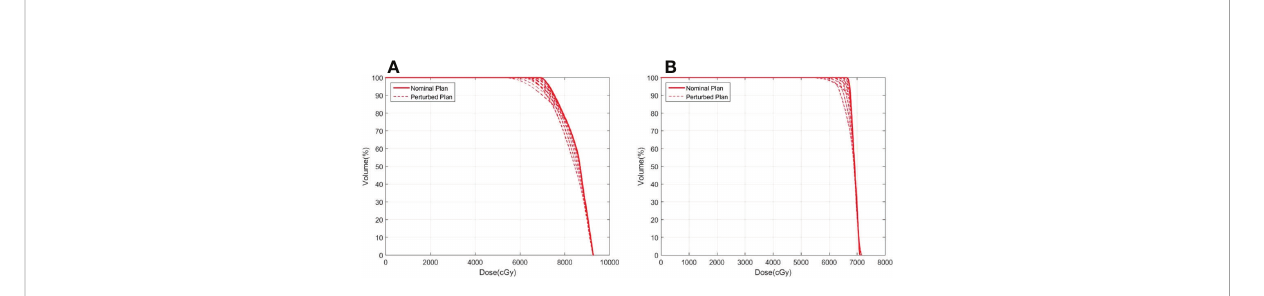
FIGURE 3 Example of ITV DVHs for plans with prescription isodoses of (A) 65% and (B) 85%. The solid line represents the nominal plan and the dashed line represents the perturbed